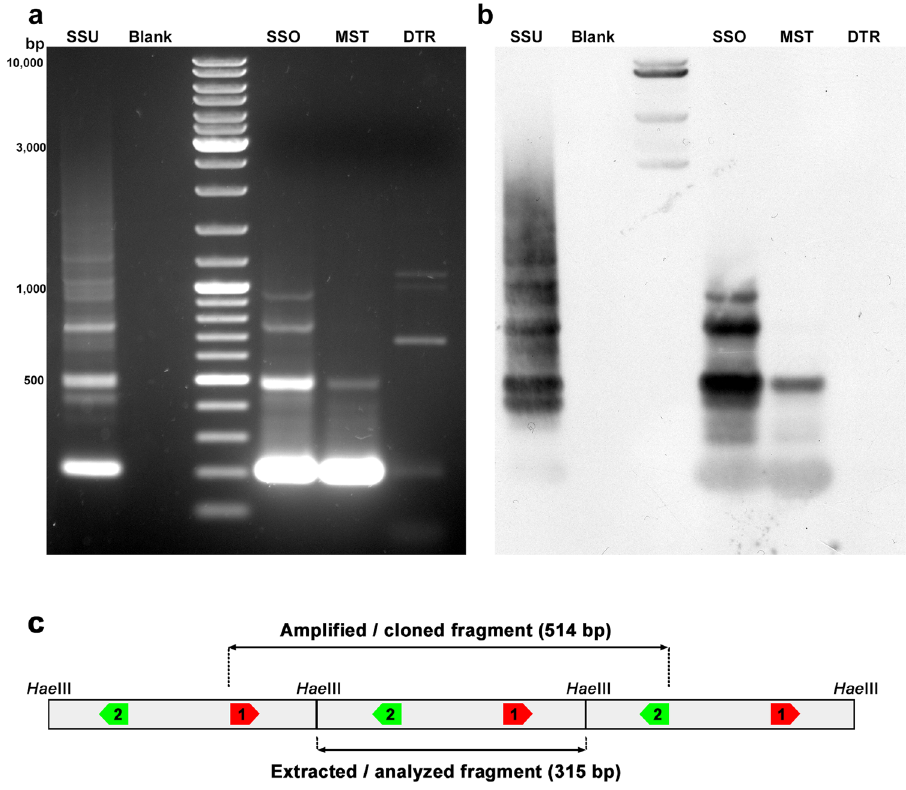
Figure 3. PCR amplification and Southern blot hybridisation of SSUsat in different bivalve species. Agarose gel electrophoresis of the SSUsat fragments obtained after PCR amplifying genomic DNA of Spisula subtruncata (SSU), Spisula solida (SSO), Mactra stultorum (MST) and Donax trunculus (DTR) using primers derived from the SSUsat consensus sequence (a) . Corresponding Southern blot hybridisation using an SSUsat probe ( b ). Blank represents PCR reaction without DNA template. ( c ) Scheme of tandemly organized SSUsat monomers showing the locations of the inversely orientated PCR primers (SSUsatPR1 in red, SSUsatPR2 in